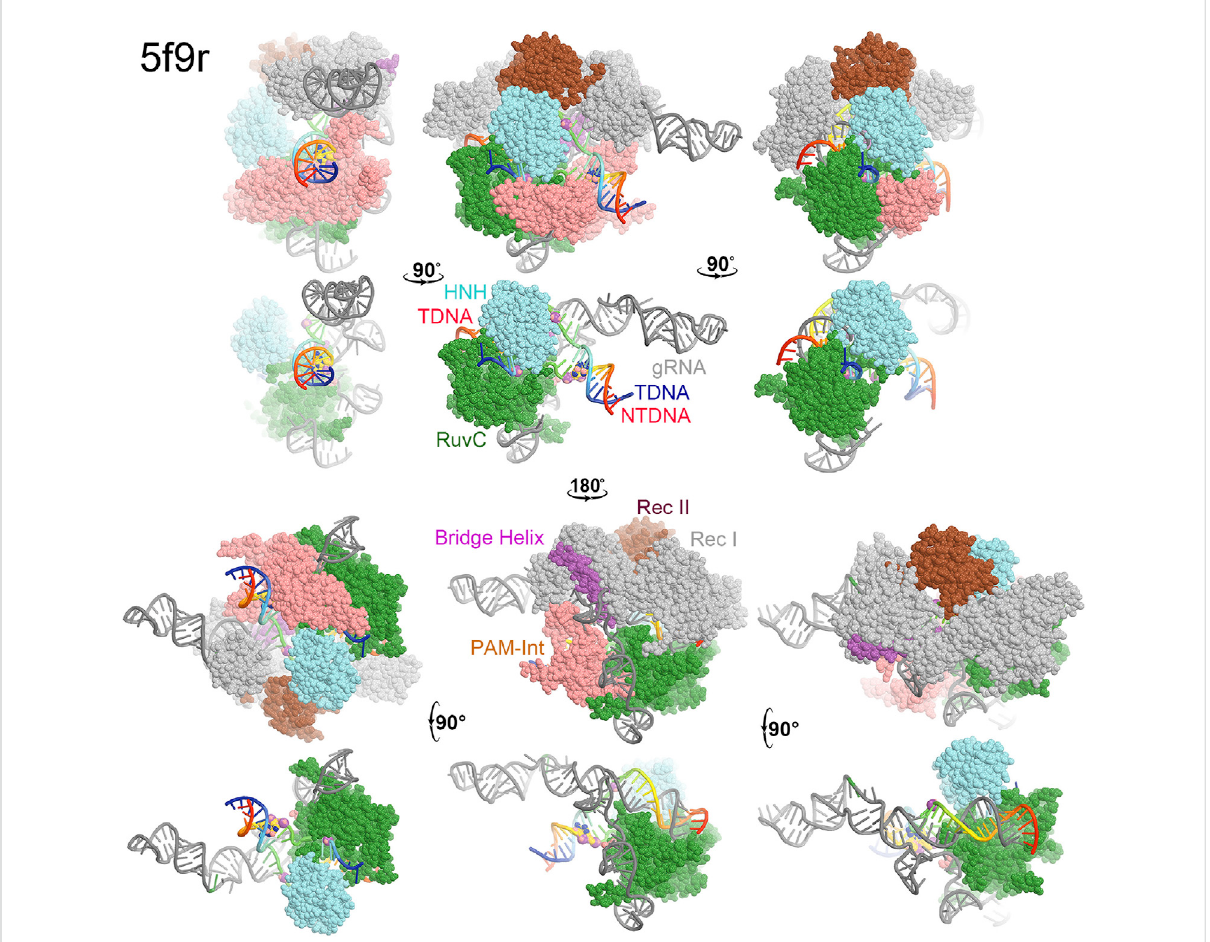
FIGURE 2 Surface representation of RuvC-catalytically relevant complexes in various orientations. Domains are colored as in Figure 1. Missing sidechains and loops were not